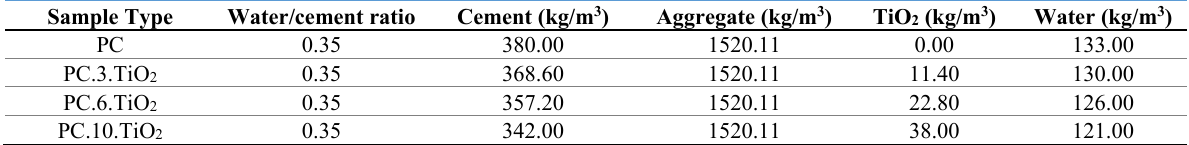
Table 4 P roportion of materials in the